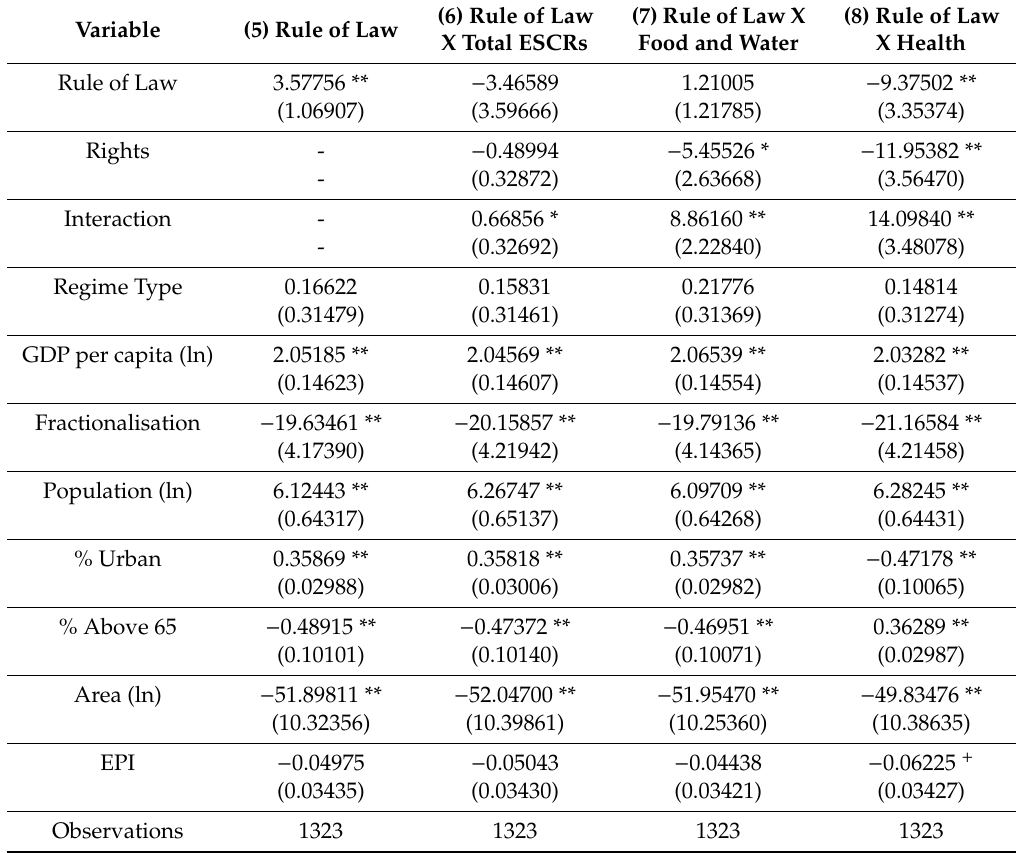
Table 3. Rule of Law, ESCRs, & Basic Water Access,